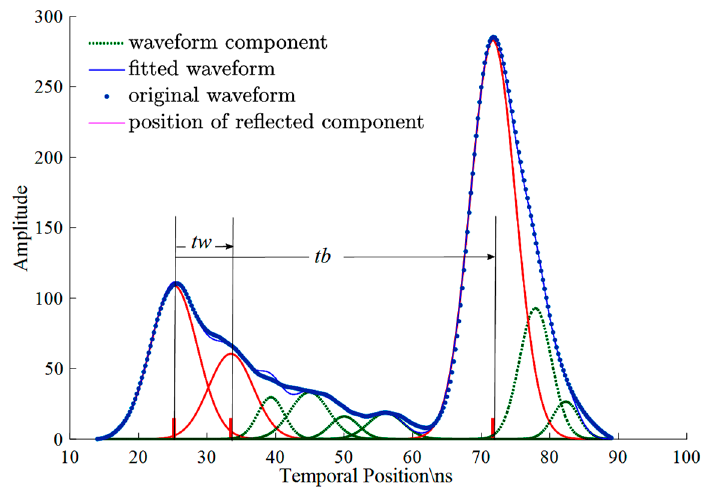
Figure 9. Component position selection.